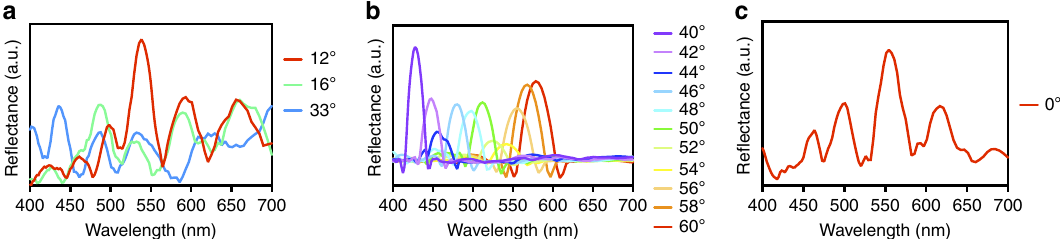
Fig. 5 Simulated re fl ectance spectra. The simulated re fl ectance spectra plotted against different viewing angles based on results from Fig. 6g – i. Each spectrum is smoothed, normalized to the highest value of spectra plotted within the panel and assigned to an arbitrary colour. a The foil grating is capable of showing all the colours in a rainbow simultaneously in many different angles, and the rainbow pattern shows up particularly well at angles 12°, 16°, and 33°. b The fl at grating can only show a single high purity colour at each viewing angle, and it takes > 20° rotation to shift the colour from one end of the spectrum to the other end (40°, peak wavelength ~ 400nm → 60°, peak wavelength just below 600 nm). c The prism grating can only show the rainbow pattern at exactly 0°. In all other angles simulated, it cannot show the rainbow pattern like the foil grating ( a ), nor high purity colours as the fl at grating ( b )